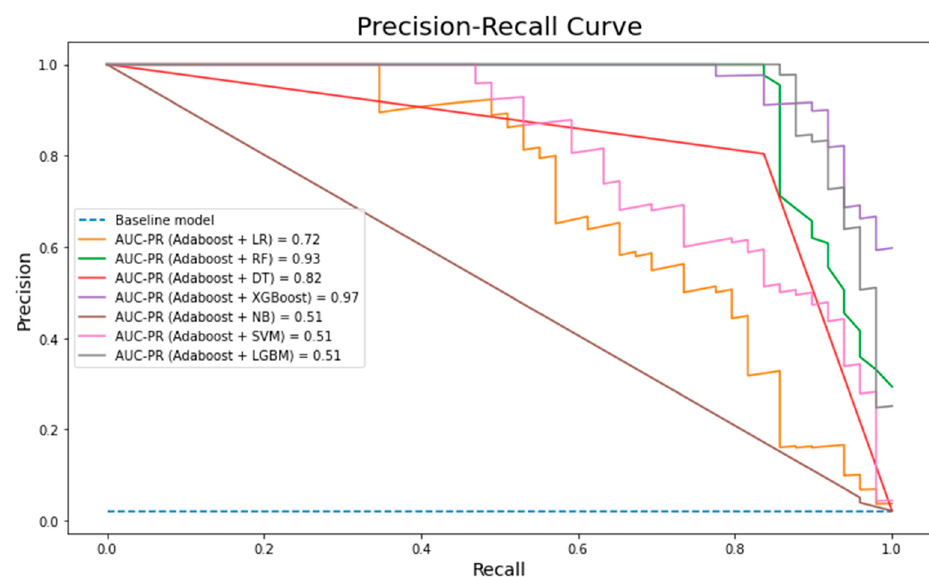
Figure 10. AUC-PR of the hybrid models.